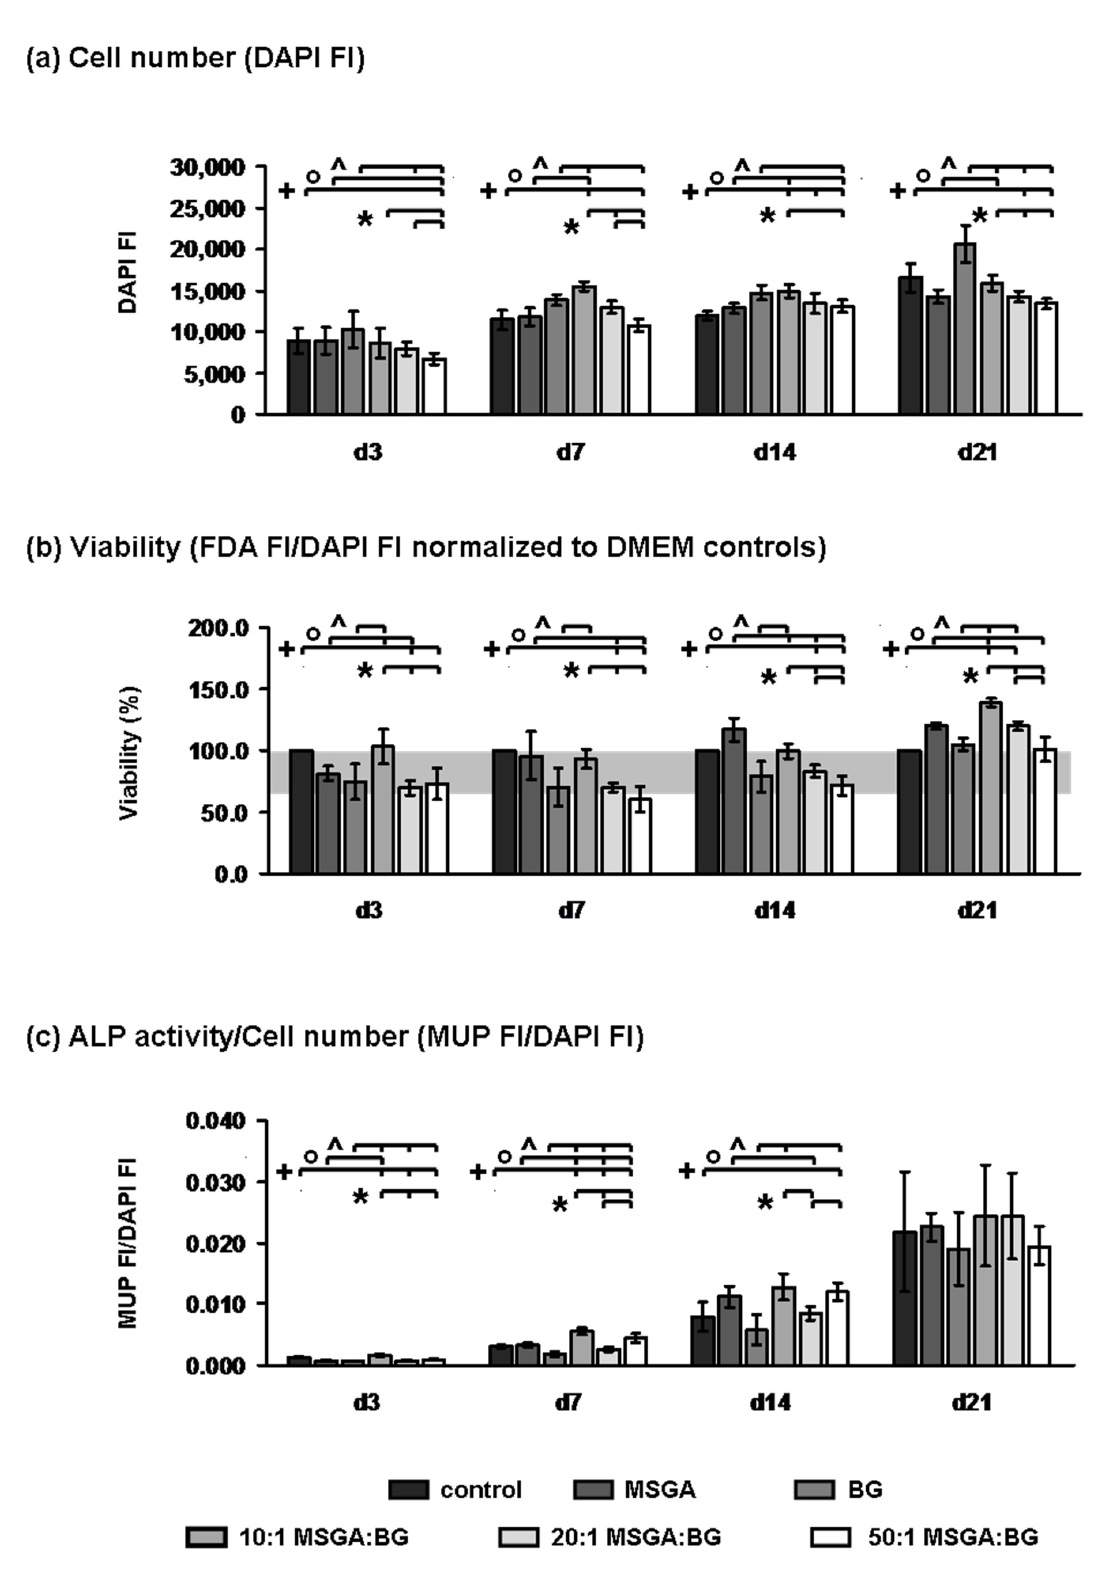
Figure 5. Impact of supramolecular complexes of MSGA:BG on cell number, viability, and ALP activity of BMSCs. Bars show mean ± SD. p < 0.05 Mann–Whitney U test control (+), MSGA ( ◦ ), or BG (^) group vs. MSGA:BG complex-treated groups, as indicated by brackets; * p < 0.5 Mann–Whitney U test between the MSGA:BG complexes treated groups as indicated by brackets. The grey box in ( b ) shows the range of 70% (threshold) to 100% viability. FI: fluorescence